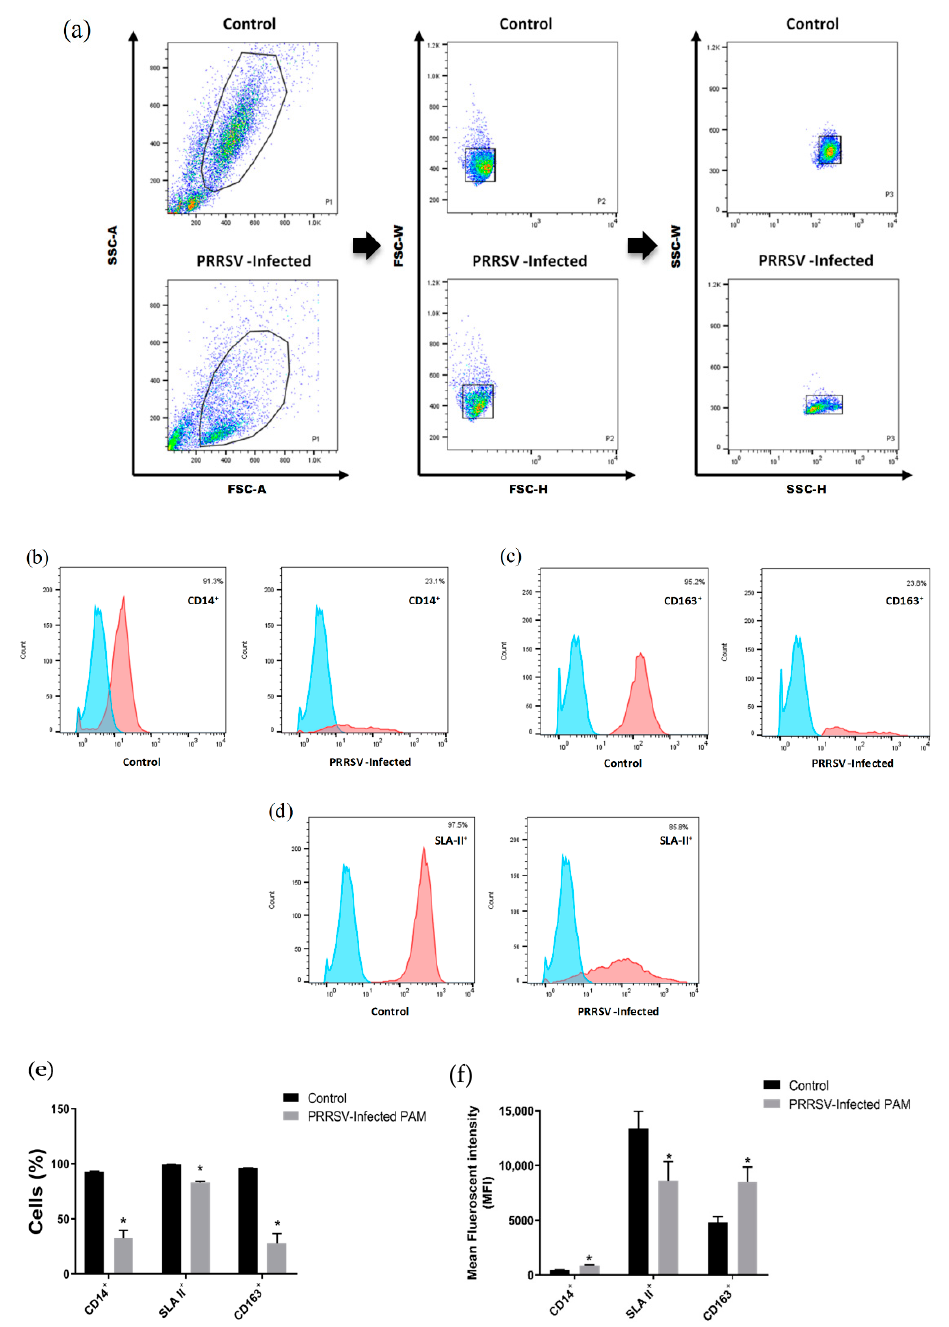
Figure 1. Surface marker expression on alveolar macrophages from animals infected with PRRSV. ( a ) Gating strategy of healthy PAMs and PRRSV-Infected PAMS. Dot plots (FSC-Area vs. SSC-Area) from a representative pig of the control and PRRSV-infected group. We excluded more dead cells in the lower levels of FSC/SSC. The circles indicate living potential of PAMs according to light scatter properties (size and granularity). The combination of width and height of FSC and SSC, respectively, indicate the singlets of cells. ( b – d ) Representative flow cytometry histogram of PRRSV-infected PAMs. Samples were calculated from three pigs (duplicate each pig). Red color histogram represents signal for each specific antibody, and blue color histogram represents unstained. Cells percentage ( e , f ) mean fluorescence intensity (MFI) of CD14 + , SLA II + and CD163 + were detected with a specific monoclonal antibody, followed by a FITC-conjugated anti-mouse antibody and analysis by flow cytometry. The level of expression of non-infected animals is included as a control. Statistical differences were established by mean ± SEM (* p <